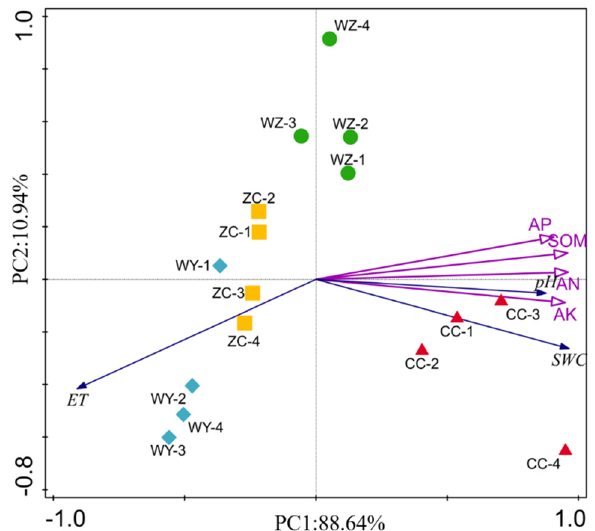
Figure 11. Principal component analysis of coal gangue pile properties. SWC: soil water content; ET: effective soil temperature; SOM: soil organic matter; AN: total nitrogen; AP: available phosphorus; AK: available potassium.